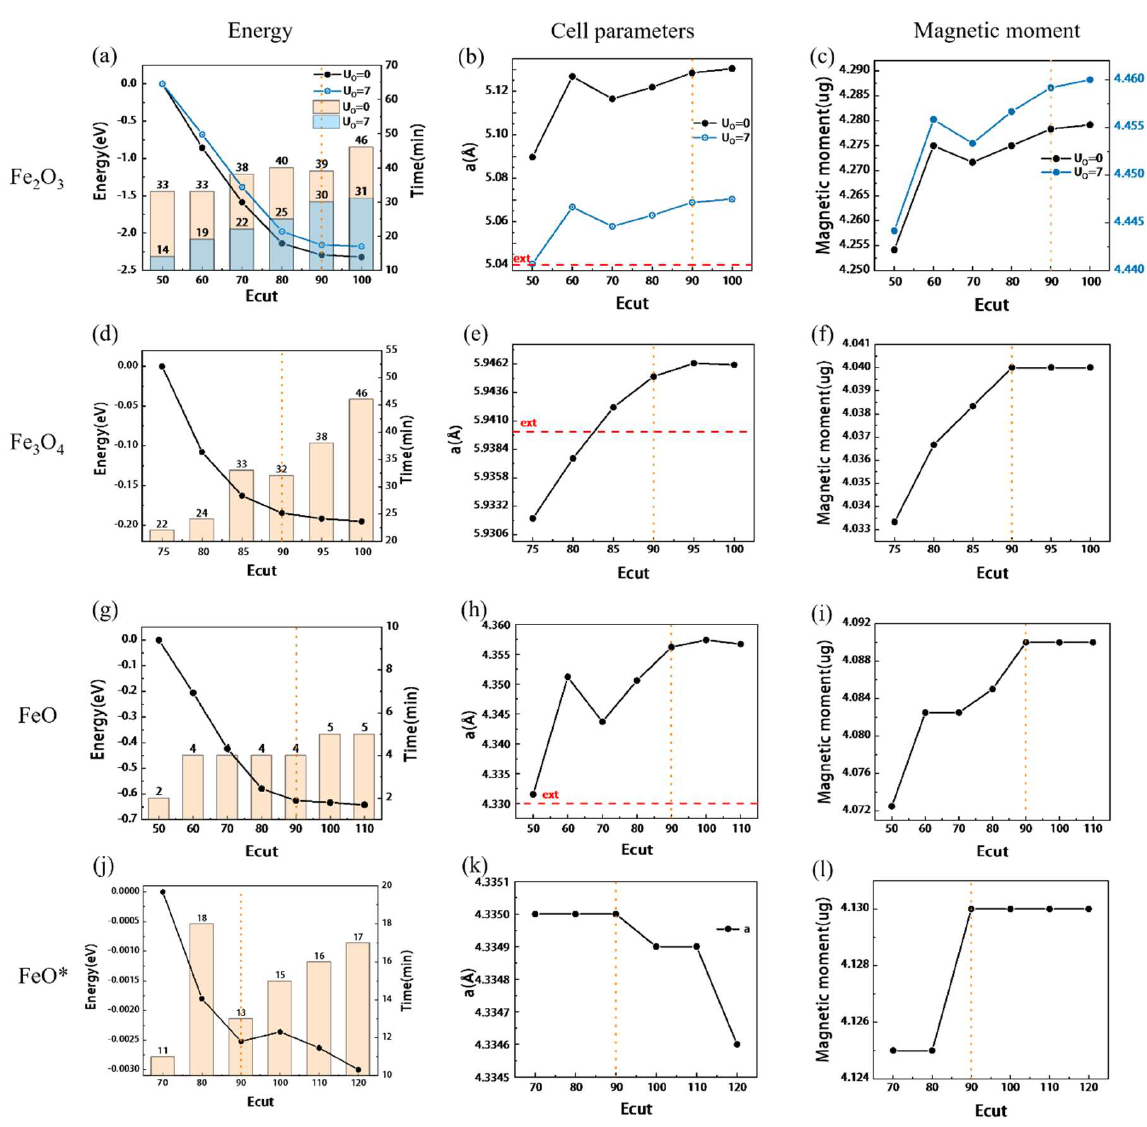
Figure 2. The test results of Ecut for three iron oxides, the horizontal direction is the parameters of the same oxide (( a – c ) for Fe 2 O 3 , ( d – f ) for Fe 3 O 4 , ( d – i ) for FeO, and( j – l ) for FeO*), and the vertical direction is the comparison of the same results. The histogram is the calculation time, the orange dotted line is the position of the final value, and the red line is the experimental value. The right coordinate axis in ( c ) corresponds to the blue line in the figure. FeO* is the result of the spin setting along